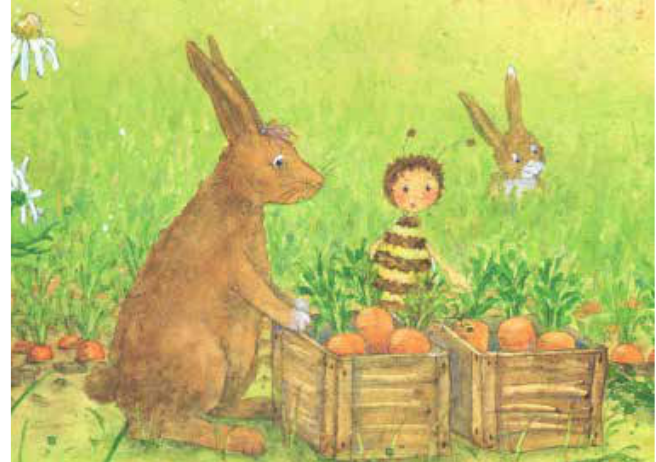
76Figure 2: Illustration for the content ‘subset change’: The rabbit Paul is surprised to find that there are still a total of 6 carrots in his 2 boxes, even if he puts carrots from one box into the other (see: storybook of Mina and the Mole , p.